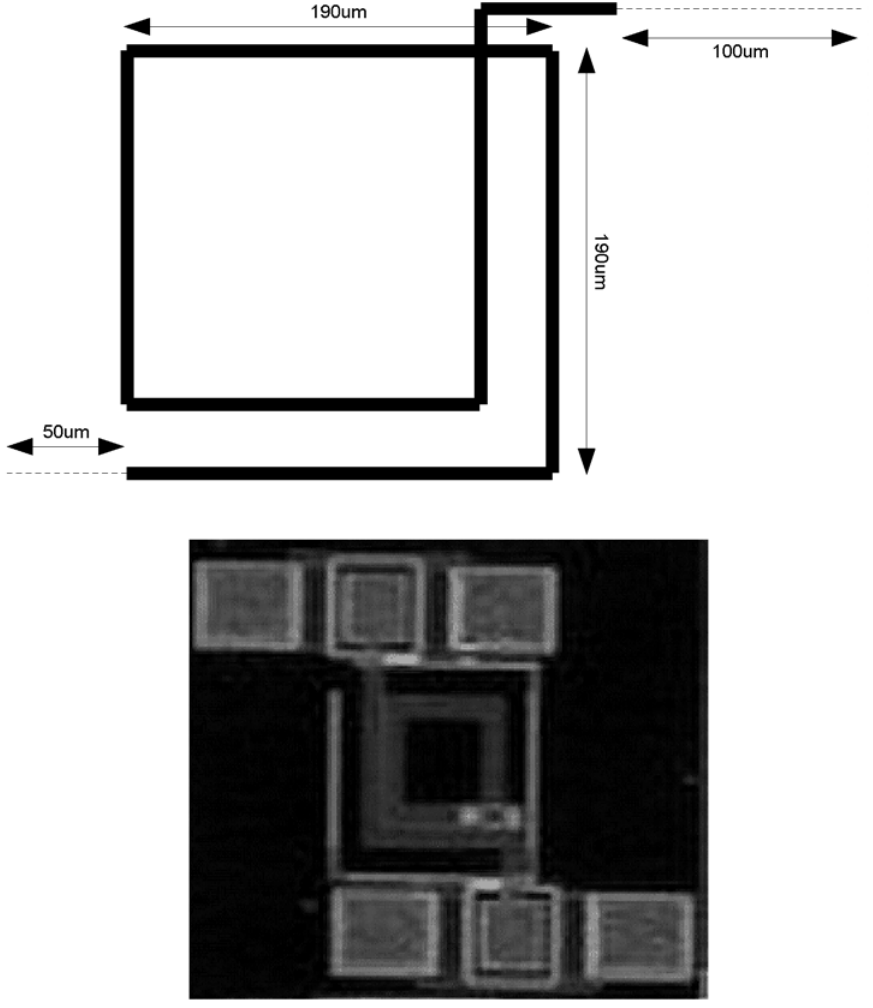
FIGURE 5 Inductor with small geometrical characteristics and its